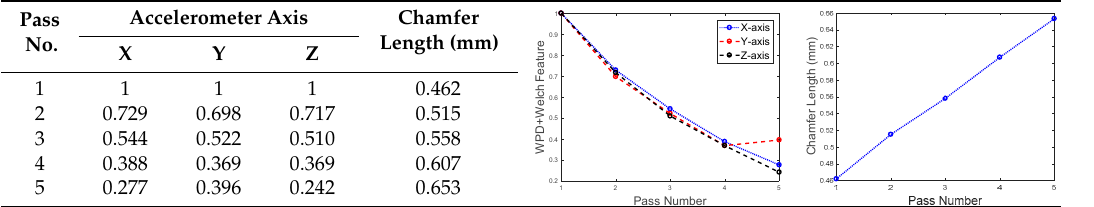
Table 3. The vibration features of the three axes for the testing data. Pass No.